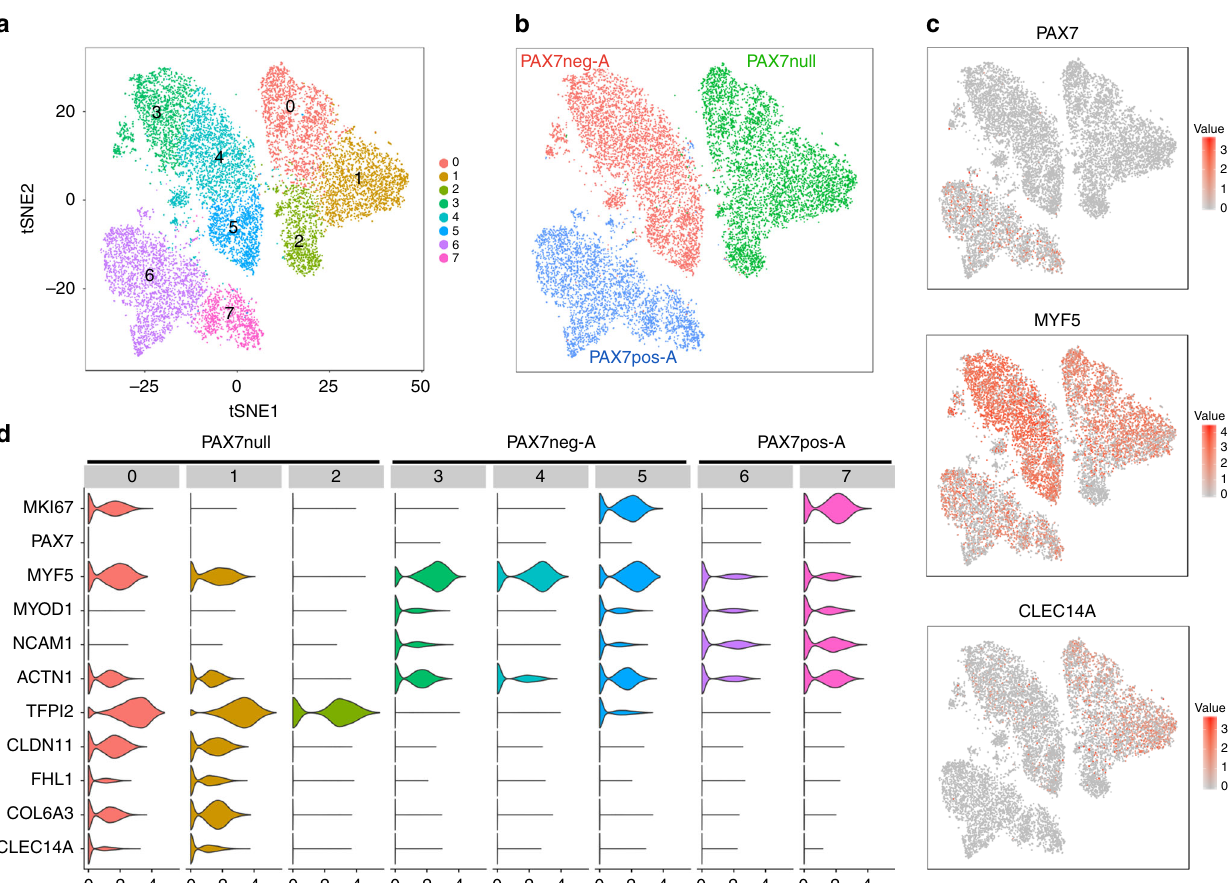
Fig. 2 Single-cell transcriptomics reveals different gene expression pattern in PAX7pos, PAX7neg, and PAX7null myogenic cells. a – c Two-dimensional tSNE representation of global gene expression relationships among individual myogenic cells from a PAX7-de fi cient donor (PAX7null) and from donor A (PAX7neg-A, PAX7pos-A). Each dot represents a cell. a tSNE plot colored by cell cluster. b tSNE plot colored by cell population. c Normalized gene expression levels of selected marker genes (red: high, gray: low). d Violin plots indicating gene expression levels and distributions of selected genes within cell clusters corresponding to panel a . Clusters 0, 5, and 7 correspond to proliferating cells ( MKI67 ). PAX7null cells express strongly elevated levels of CLDN11, FHL1, COL6A3, and CLEC14A in clusters 0 and 1, and TFPI2 in clusters 0, 1, and